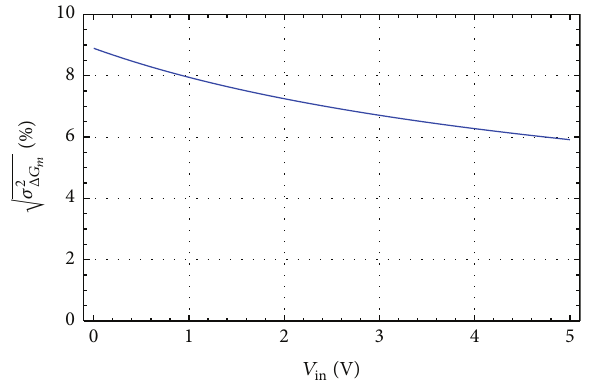
( % ) of the FGMOSFET based transconductor Figure 8: √𝜎 2 Δ𝐺 𝑚 against |𝑉 in |